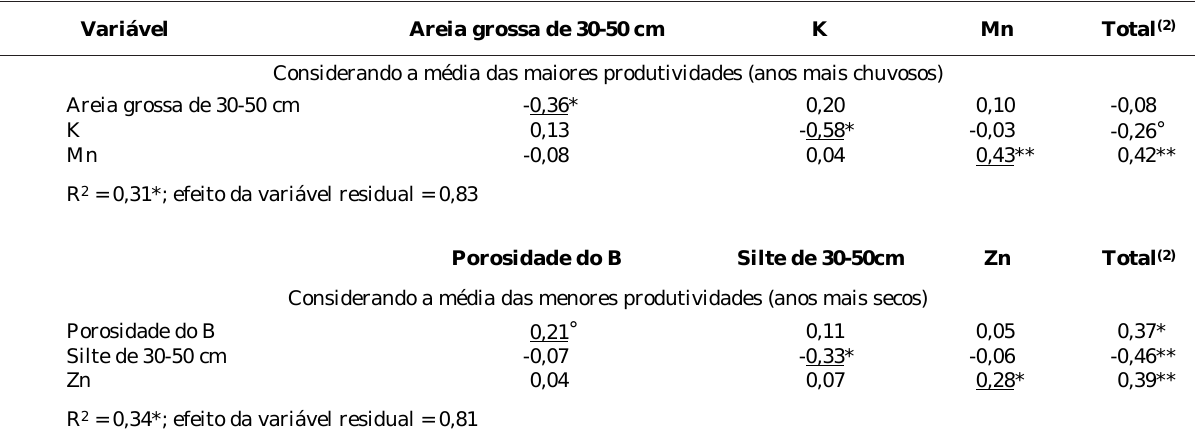
Quadro 4. Desdobramentos das correlações em efeitos diretos e indiretos (1) , entre a produtividade média do cacaueiro e características físicas da subsuperfície do solo (camada de 30-50 cm ou do horizonte B) e teores de alguns elementos extraídos pelo ataque sulfúrico (camada de 30-50 cm), de 36 talhões de cacau